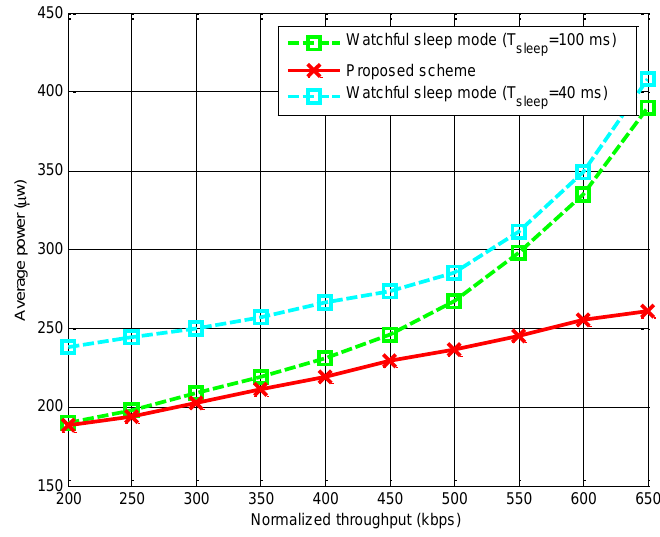
Figure 13. Comparison of the average power .